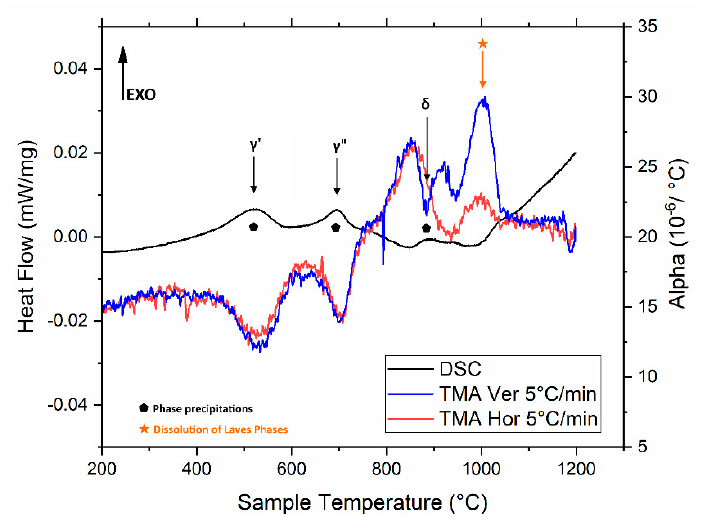
Figure 2. Thermomechanical analysis (TMA) of as-built IN718. Heating rate is 5 °C/min. The relevant DSC curve is presented as well.